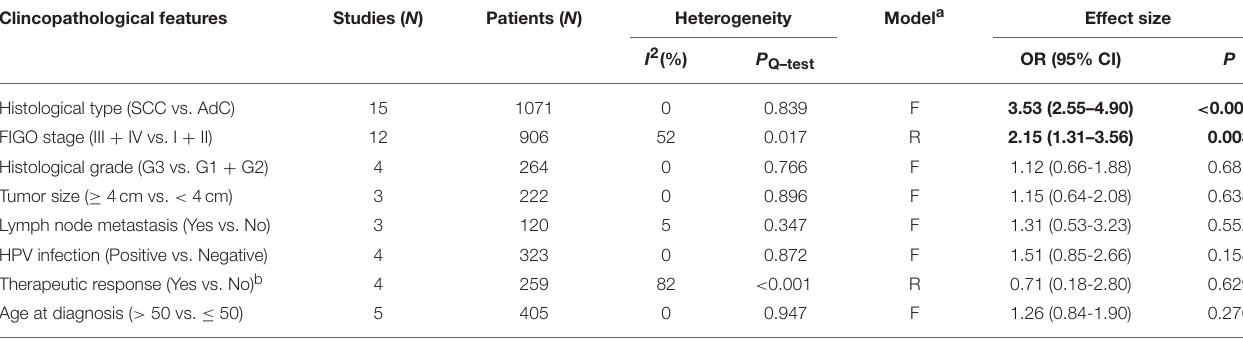
TABLE 5 | Pooled results for the associations between DAPK1 promoter hypermethylation and clincopathological features of CC. Clincopathological features Studies ( N